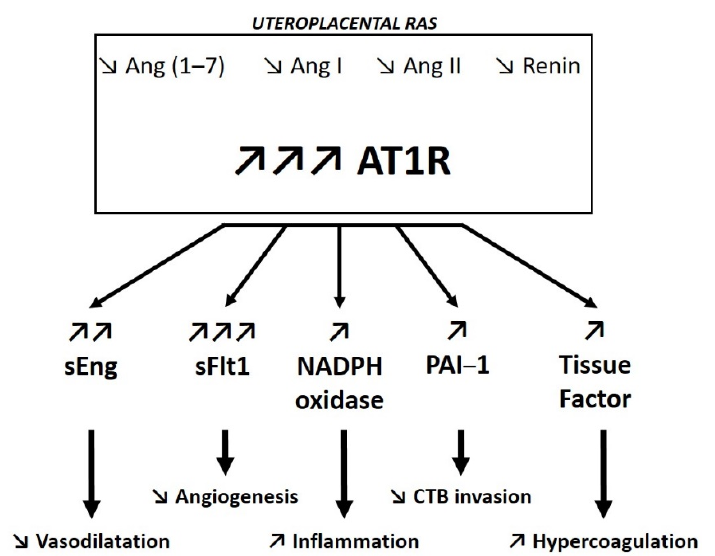
Figure 4. Uteroplacental renin–angiotensin system (RAS) dysfunction in preeclamptic women compared to normotensive pregnant women. Ang (1–7): angiotensin (1–7); Ang I: angiotensin I; Ang II: angiotensin II; AT1R: angiotensin II type 1 receptor; sEng: soluble endoglin; sFlt1: soluble Fms-like tyrosine kinase 1; NADPH: Nicotinamide Adenine Dinucleotide Phosphate Hydrogen; PAI-1: plasminogen activator inhibitor 1; CTB: cytotrophoblasts.